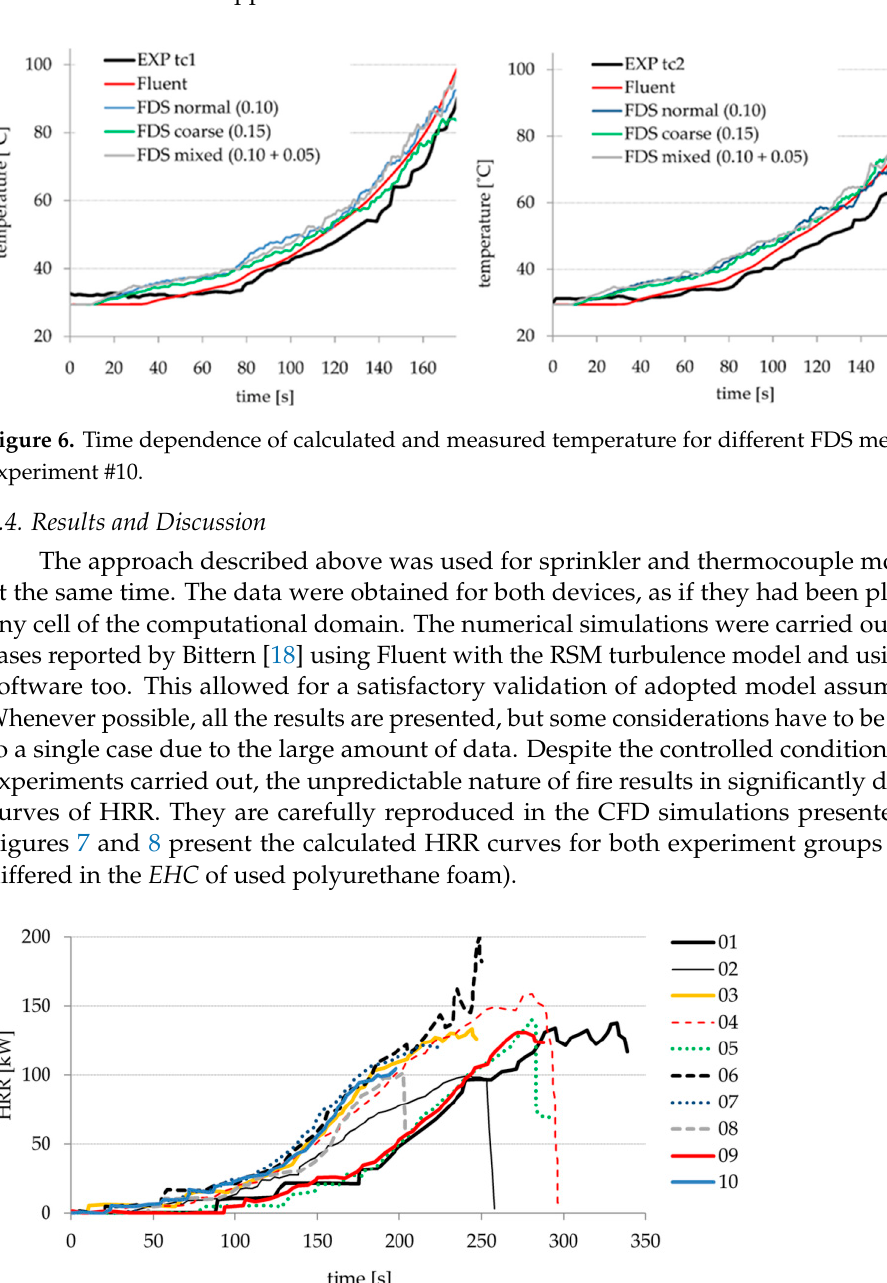
Figure 8. HRR curves for experiments 12–22. 3.4.1. Results of Sprinklers Activation Modeling In this section the results concerning sprinklers SPR1 and SPR2 are considered. The sprinkler parameters were adopted according to the data in Tables 1 and 2. The sprinklers are assumed to be mounted 0.015 m below the ceiling. Since the value of the C parameter may differ from the nominal value (0.4) by up to 10%, values of C = 0.35 and C = 0.45 were checked as well . It was possible, thanks to the ability of the proposed approach, to exam- ine many sprinkler types at the same time. All results concerning sprinklers activation times for the nominal value of the C parameter are presented in Table 7. If a table entry is left blank, a sprinkler was not activated during an experiment or a simulation.